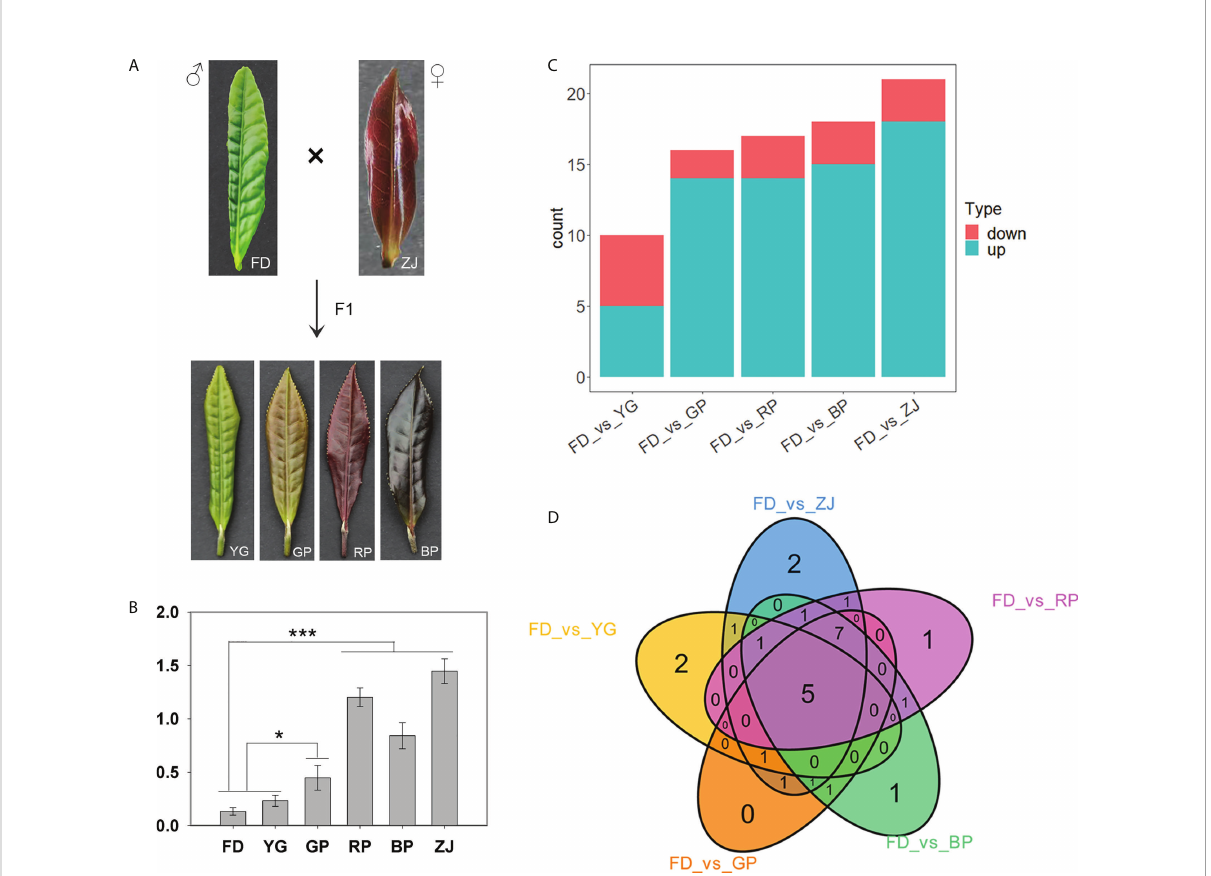
FIGURE 1 Metabolic pro fi ling of the parents and F1 hybrid progenies. (A) The morphological phenotypes of the parents and F1 hybrid progenies; (B) The anthocyanin content of parents and hybrid progenies; (C) Differential metabolites in various groups; (D) Venn diagram of differential metabolites between 5 groups. “ * ” : p < 0.05; “ *** ” : p <